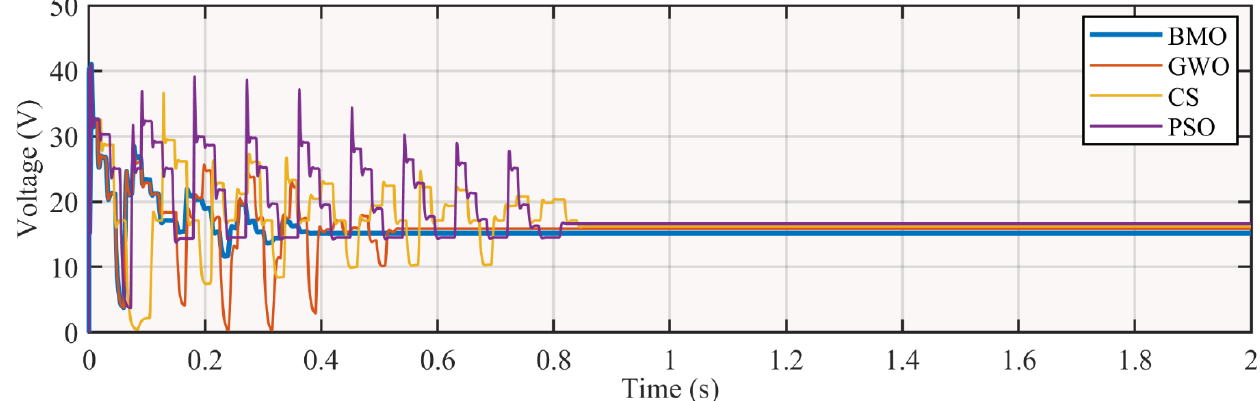
Figure 11. Competing techniques voltage Case-1.